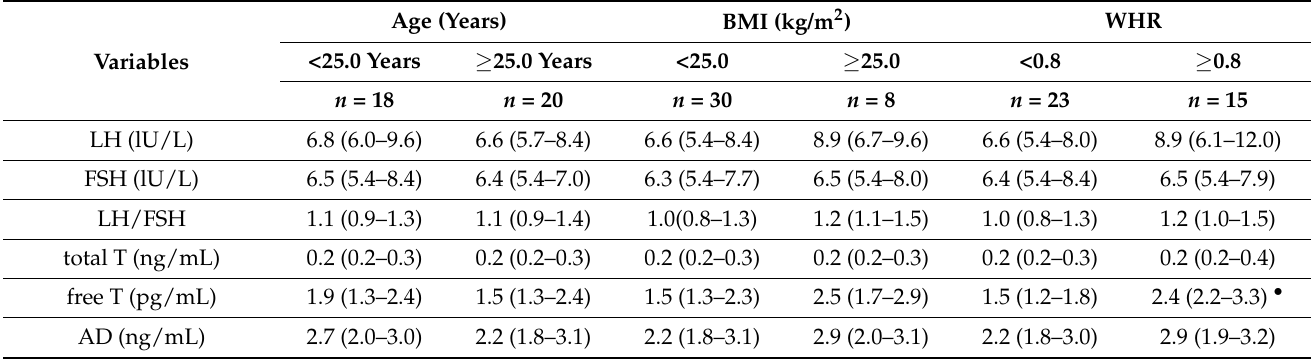
Table 3. Hormone status in the studied groups divided according to age, BMI and WHR